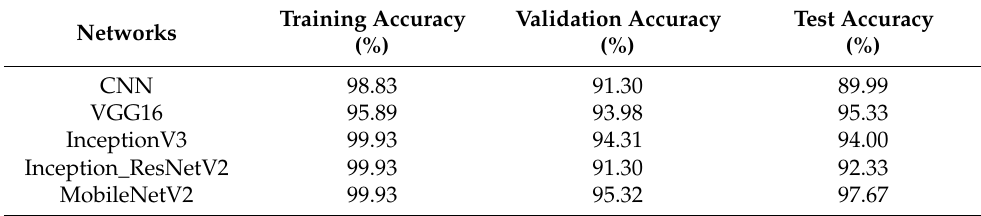
Table 3. Performance measures and comparison of different transfer learning